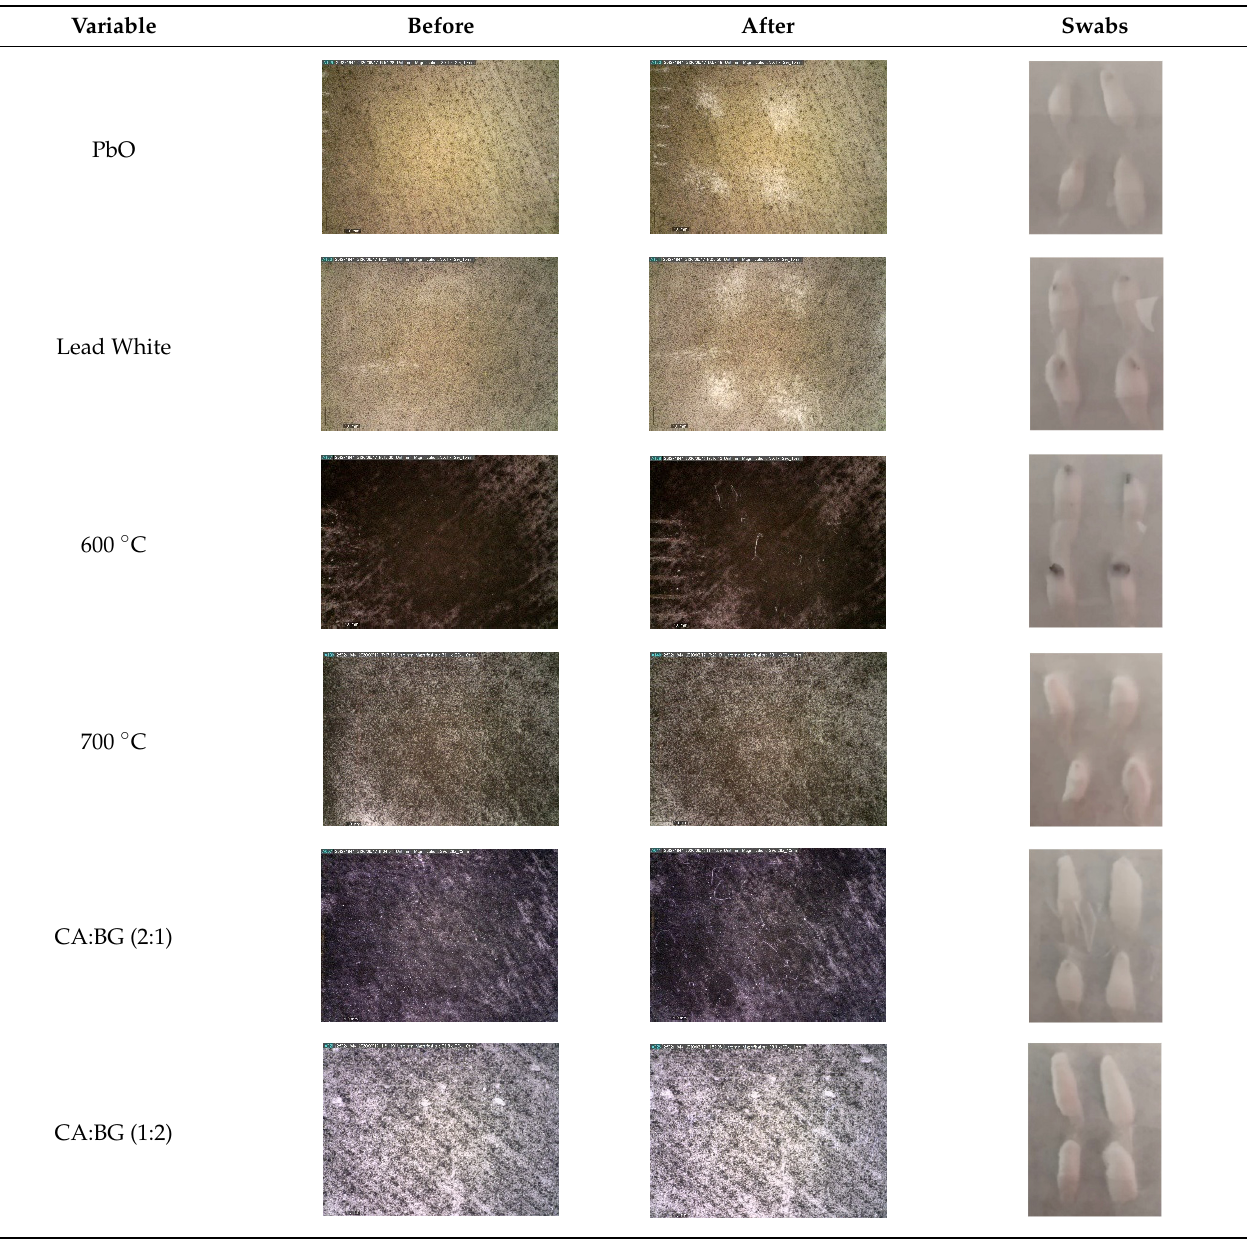
Table 7. Cont . Before After